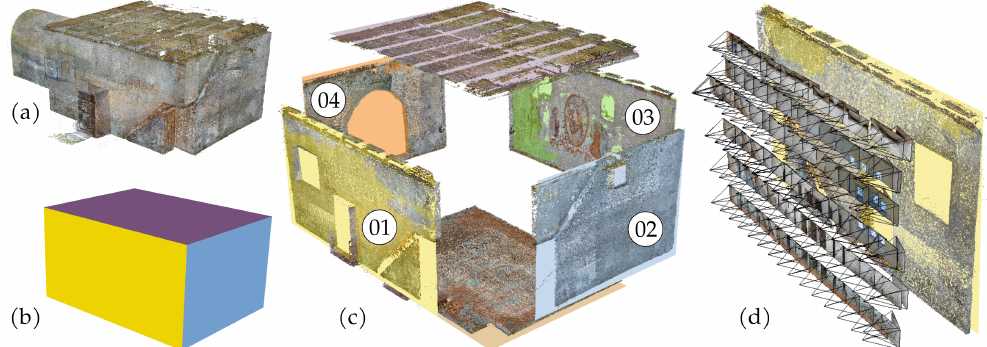
Figure 3. Segmented building parts of the main hall with manually modelled building elements: ( a ) initial point cloud of the interior, ( b ) modelled facets for floor, walls, and ceiling, ( c ) explosion drawing of the point cloud segments including the numbering of the walls, and ( d ) subset of Wall 01 with the extracted image set as camera orientations from the